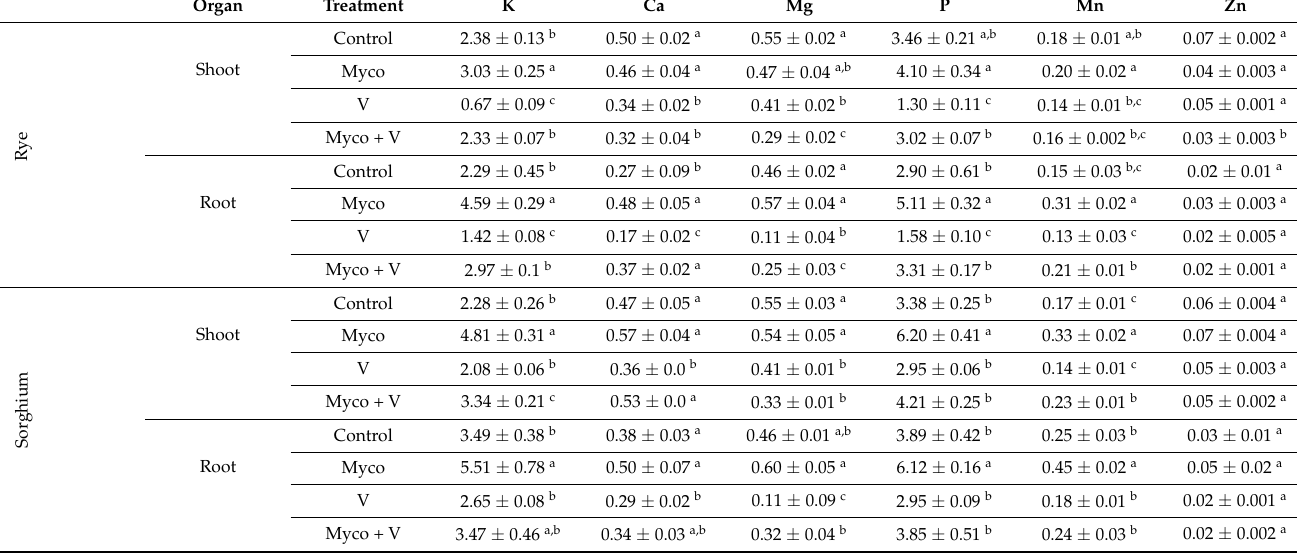
a,b,c Different letters indicate statistically significant difference between means of the same plant species at a significance level of at least ( p ≤ 0.05). “nd” means not